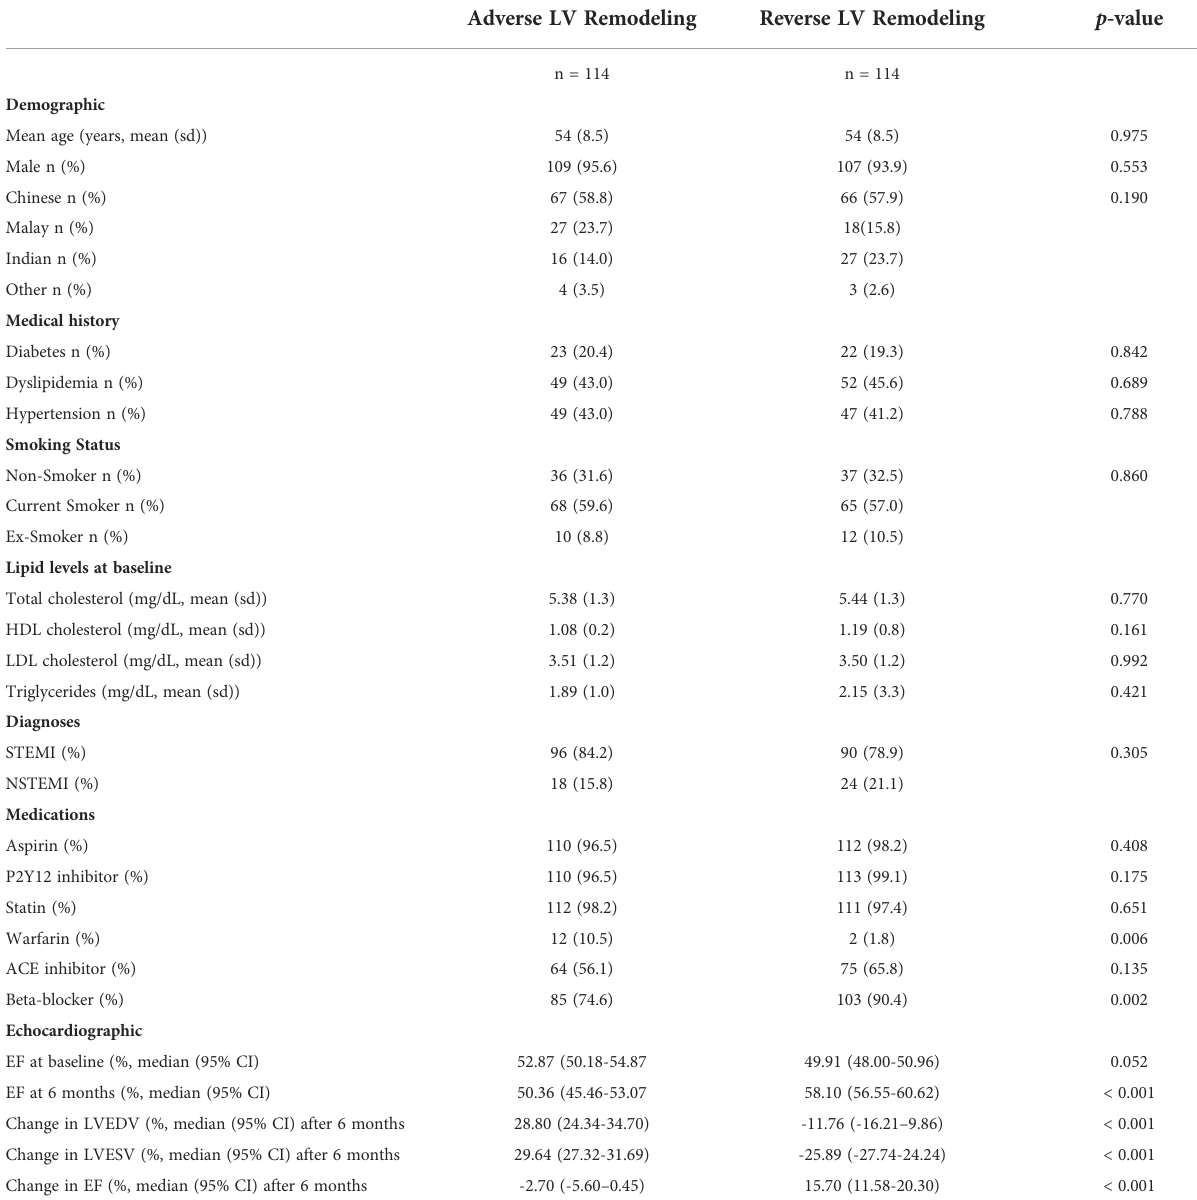
TABLE 1 Baseline characteristics of the Post-AMI